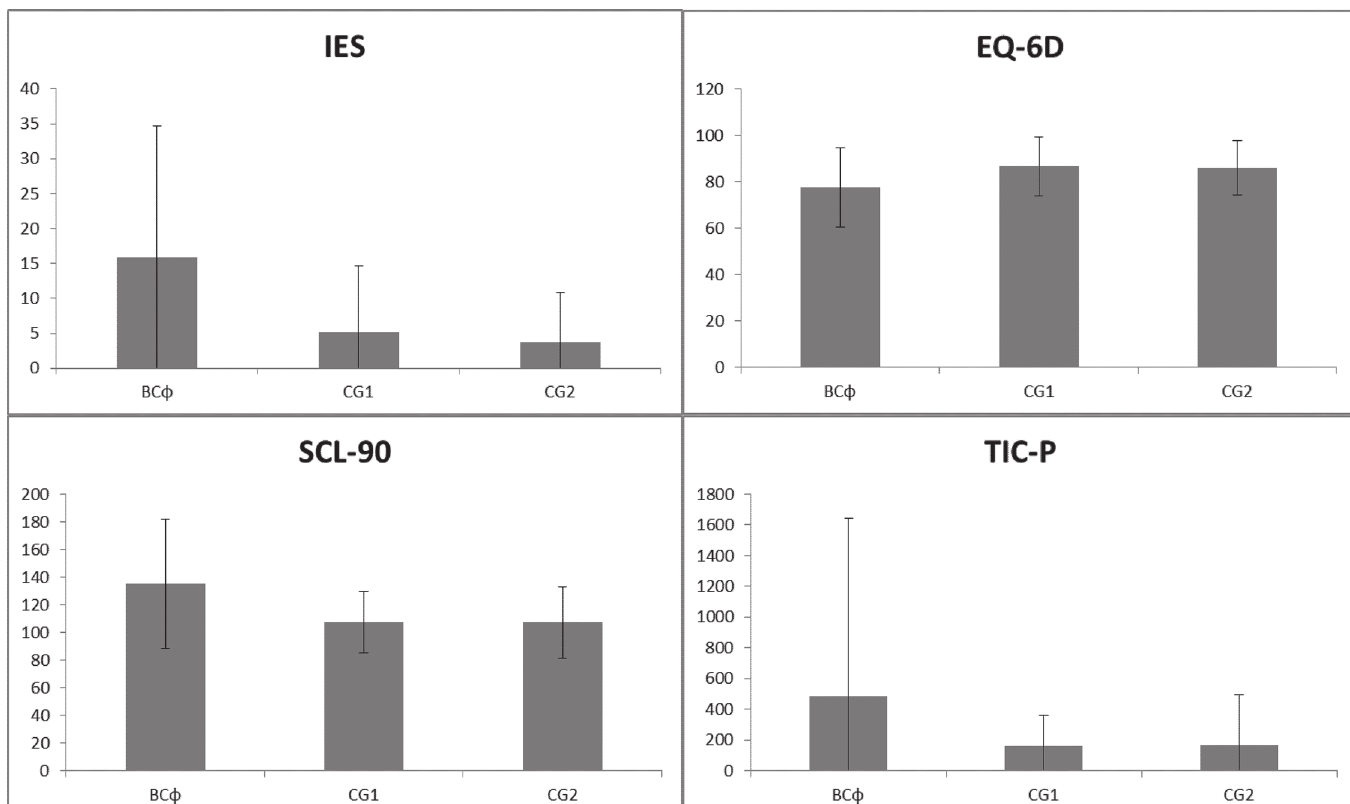
Fig 2. Schematic overview of mean scores of the IES, SCL-90, EQ-6D and TIC-P per subgroup.